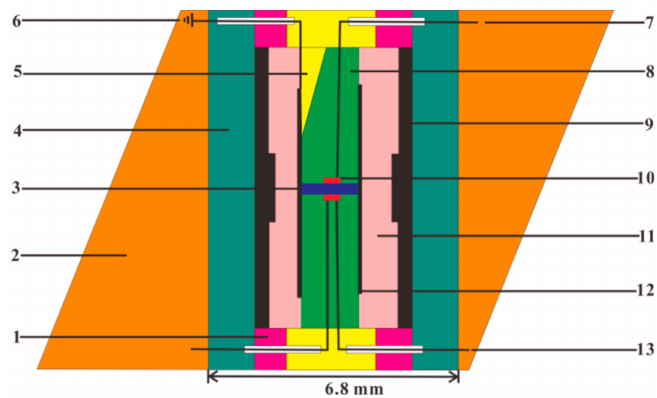
Figure 5. Experimental assemblage for EC measurements in the Kawai-1000t multi-anvil